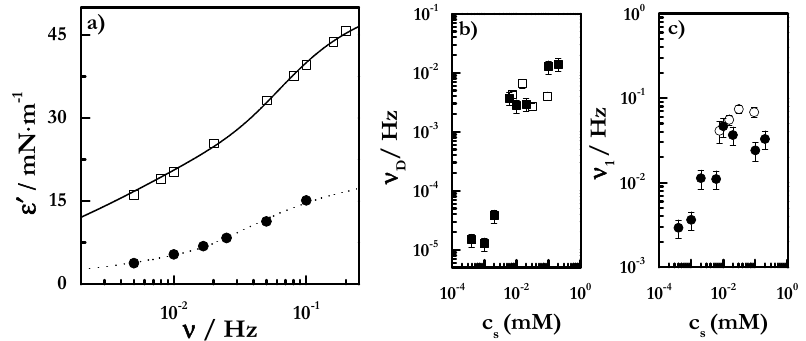
Figure 6. ( a ) Examples of frequency dependences of the elastic modulus for interfacial layers of PDADMAC-SLMT ( □ ) and PDADMAC-SLES ( ● ) and for solutions with surfactant concentration of 0.1 mM. Symbols represent the experimental data and the lines are the theoretical curves obtained from the analysis of the experimental results in term of the theoretical model described by Equation (2). ( b ) Concentration dependences of ν D for PDADMAC-SLMT ( □ ) and PDADMAC-SLES ( ■ ). ( c ) Concentration dependences of ν 1 for PDADMAC-SLMT ( ○ ) and PDADMAC-SLES ( ● ). ( b , c ) Symbols represent the experimental data and the lines are guides for the eyes. The results correspond to PDADMAC-surfactant mixtures containing a fixed PDADMAC concentration of 0.5 wt.%, and left to age for one week prior to measurement.